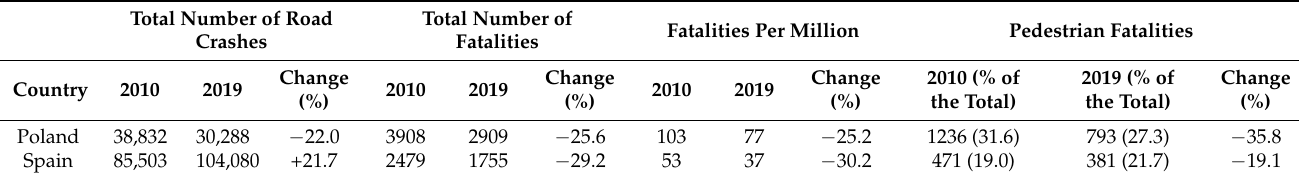
Table 1. Road safety data from Poland and Spain in 2010 and in 2019.